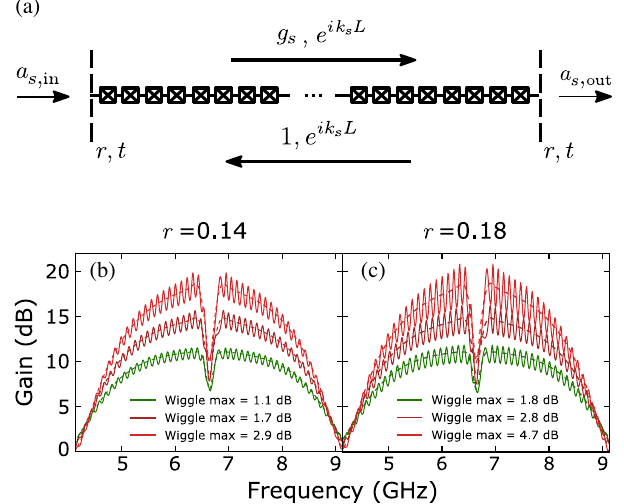
FIG. 11. (a) Modeling of the STWPA as a pumped Fabry-Perot cavity. Both input and output of the STWPA are modeled as semireflective mirrors with transmission coefficient t and reflec- tion coefficient r ( t 2 þ r 2 ¼ 1 ). We consider that the counter- propagating signal is not amplified [see Fig. 4(a)]. (b) Signal ¼ 0 . 4 I power gain for different pump current I (green: I , p p c ¼ 0 . 45 I ¼ 0 . 5 I brown: I , and red: I ). Larger pump current p c p c leads to higher maximum gain and larger ripples. The reflection coefficient is set to r ¼ 0 . 14 (c) Same parameters, but the reflection coefficient r ¼ 0 . 18 . As expected, ripples have higher